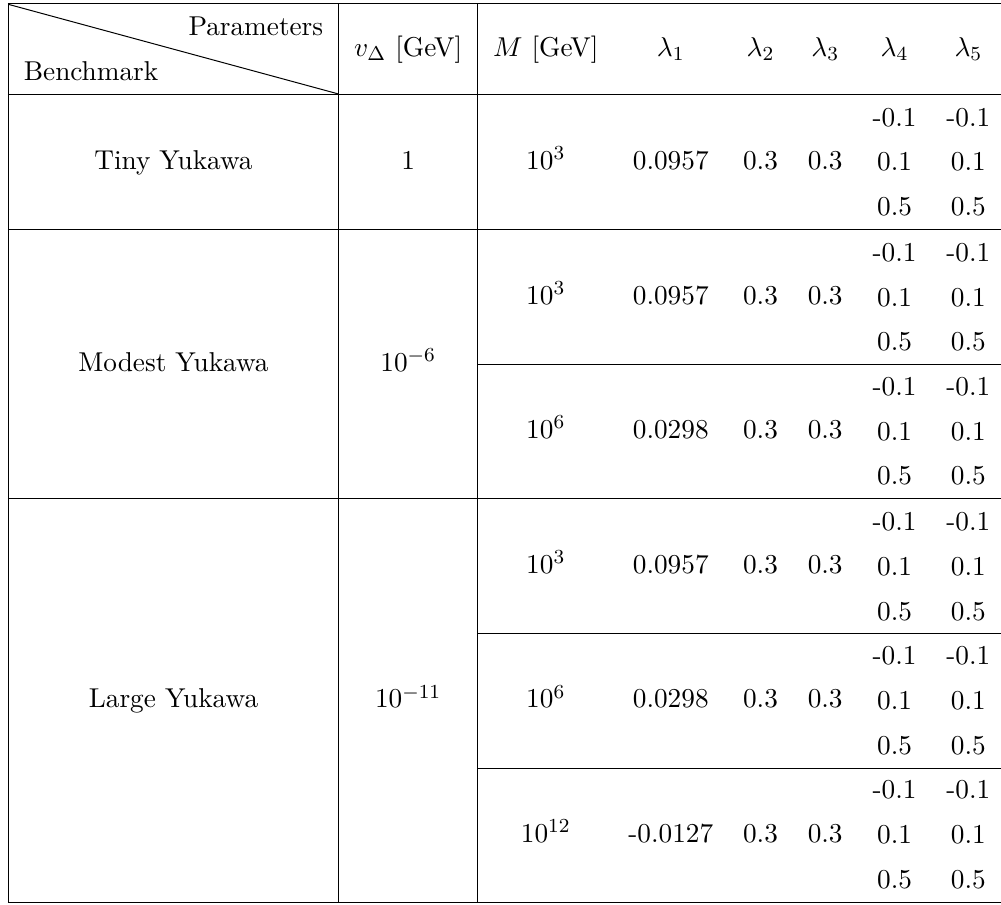
Table 11 . Benchmark points for the type-II seesaw model for illustrating radiative generated electroweak spontaneous symmetry